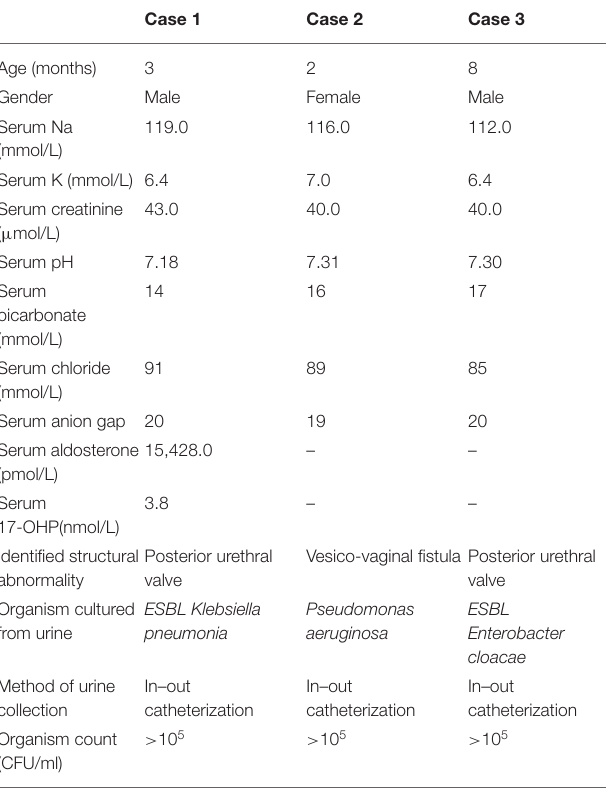
TABLE 1 | Clinical characteristics and laboratory data of infants with severe